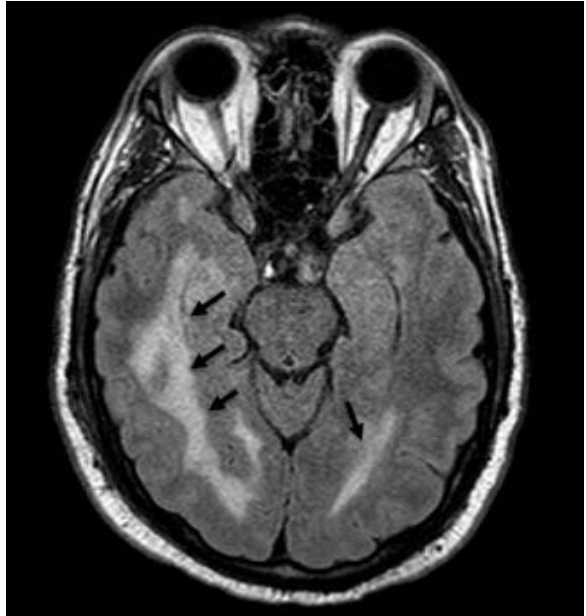
T2/weighted-fluid-attenuated inversion recovery signal representing ventriculitis consistent with cryptococcal